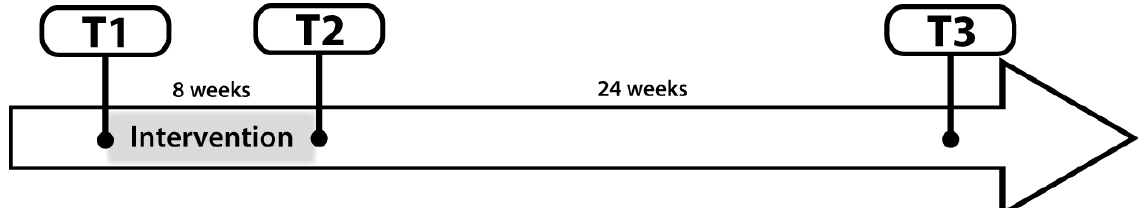
Figure 1. Study pre-experimental